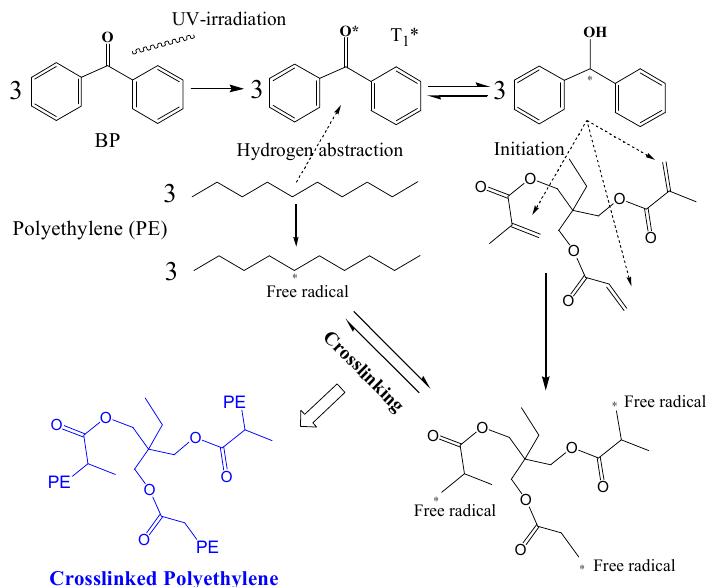
Figure 1. Schematic illustration of UV-initiated crosslinking reactions employing TMPTMA as auxiliary crosslinking agent.